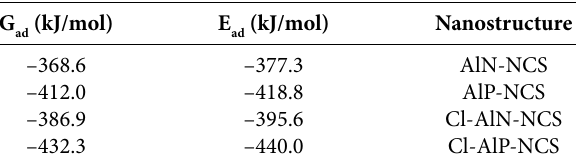
Table 2. Calculated orbital energy amounts of AlN-NCS, AlP-NCS, Cl-AlN-NCS and Cl-AlP-NCS.